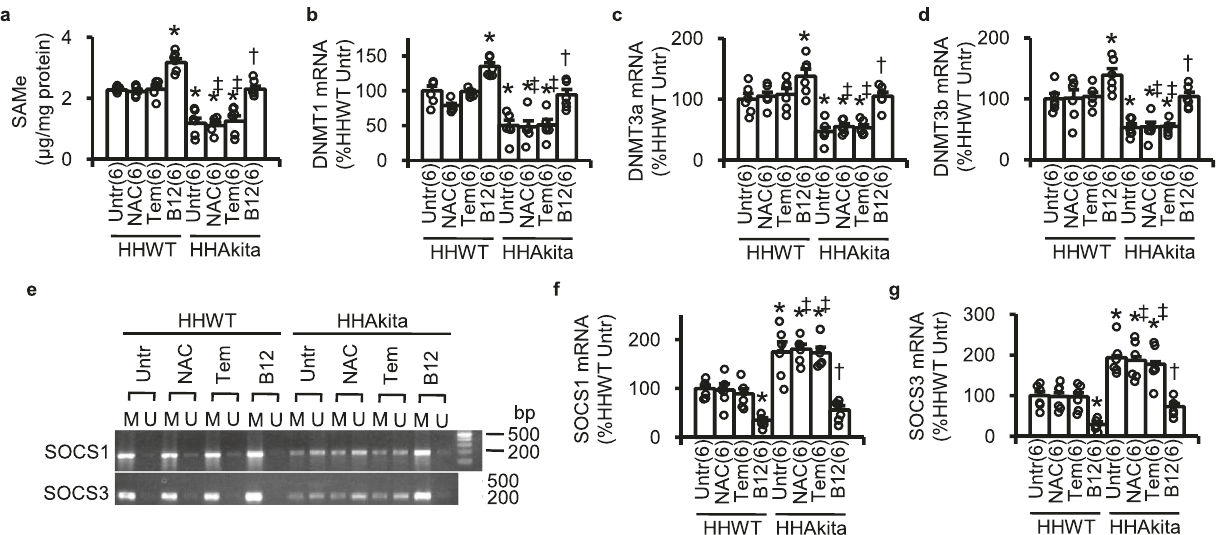
Fig. 6 Effects of orally administered NAC, tempol (Tem), and B12 on the parameters related to the DNA methylation and expression of the suppressor of cytokine signaling (SOCS) 1 and 3. a Liver S-adenosylmethionine (SAMe) levels. b Liver DNA methyltransferase (DNMT) 1 mRNA levels. c Liver DNMT3a mRNA levels. d Liver DNMT3b mRNA levels. e PCR products ampli fi ed with methylation (M) and unmethylation (U)-speci fi c primer sets for the promoters of SOCS1 and SOCS3 using 50ng bisul fi te-treated liver DNA. f Liver SOCS1 mRNA levels. g Liver SOCS3 mRNA levels. HHWT, Elmo1 H/H Ins2 + / + ; HHAkita, Elmo1 H/H Ins2 Akita/ + . Data are expressed as means±standard errors. The numbers of animals analyzed are given in the parentheses. mRNA levels normalized by β -actin mRNA are expressed relative to the mean levels in untreated HHWT mice as 100%. * P <0.05 vs. untreated (Untr) HHWT mice by Tukey – Kramer Honestly Signi fi cant Differences test after one-way ANOVA; † P <0.05 vs. untreated HHAkita mice. ‡ P <0.05 vs. B12-treated HHAkita mice.